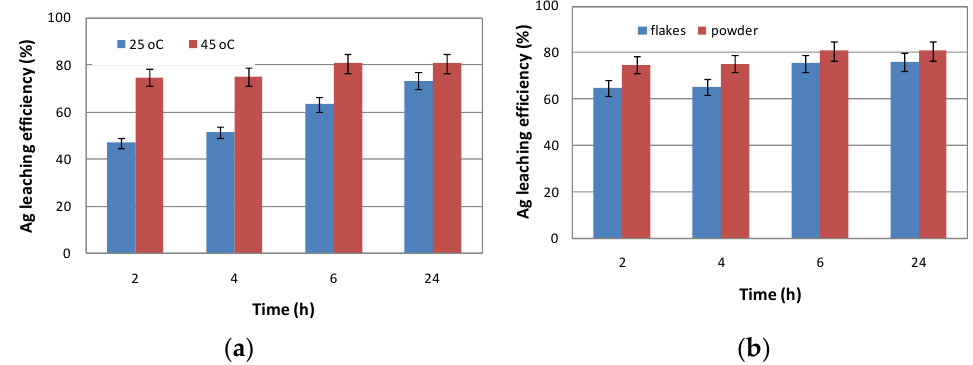
Figure 6. The effect of ( a ) temperature and ( b ) milling on Ag leaching (2 N HNO 3 , L/S = 10, m-Si sample).